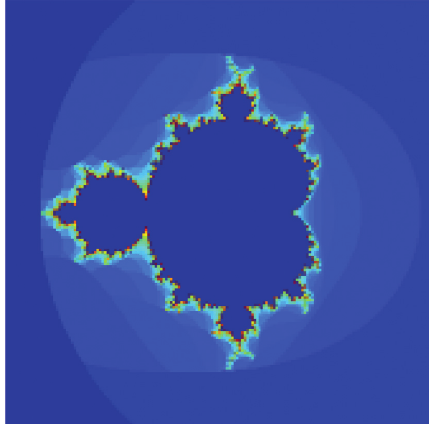
Figure 3: The general Mandelbrot for the critical point ( 0 , i /2 ) of P ( z ) 2